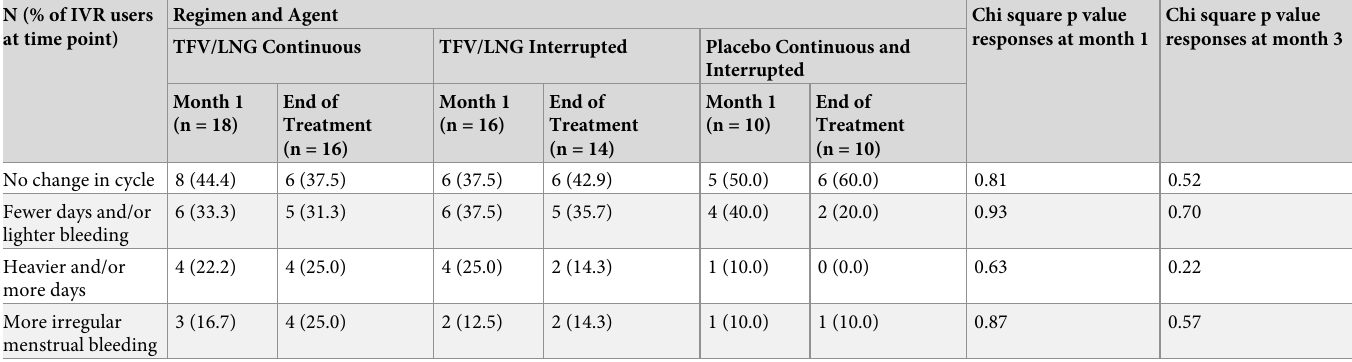
Table 8. Reported impact of IVR use on menstruation (percent of participants per group reporting impact, participants may report more than one menstrual related impact). N (% of IVR users Regimen and at time point)